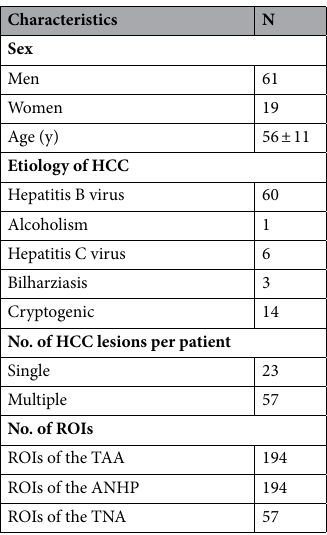
Table 2. Patients and lesions characteristics on DECT. The data are represented as the mean ± standard deviation or number of patients. HCC , hepatocellular carcinoma; ROIs, regions of interests; TAA, tumor active area; ANHP, adjacent normal hepatic parenchyma; TNA, tumor necrotic area.